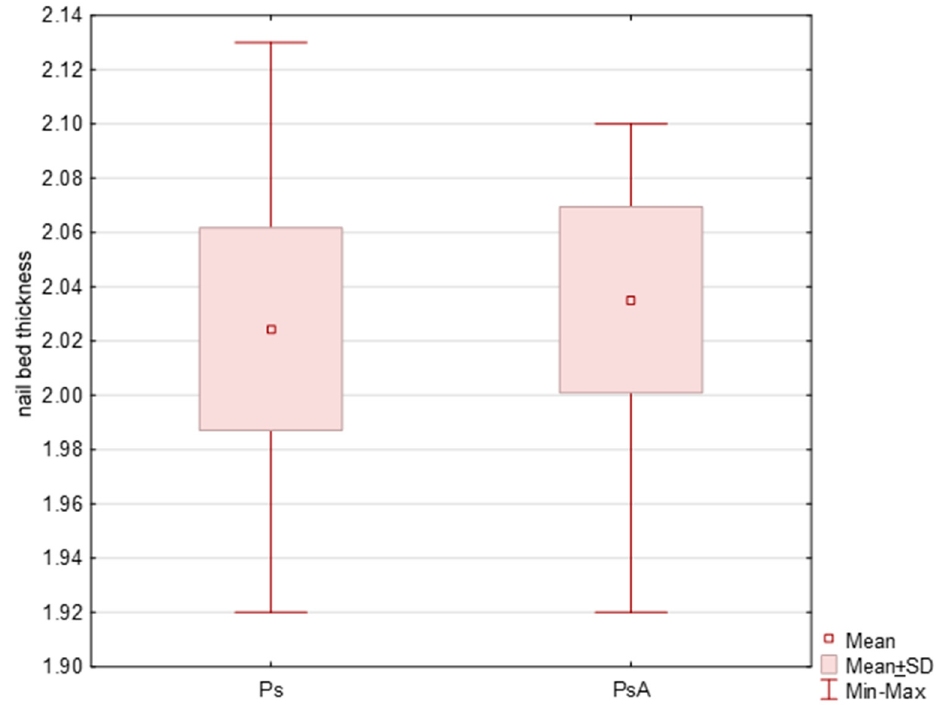
Figure 2. Initial US measurements of nail bed thickness in patients studied. p < 0.001. Ps: psoriasis, PsA: psoriatic